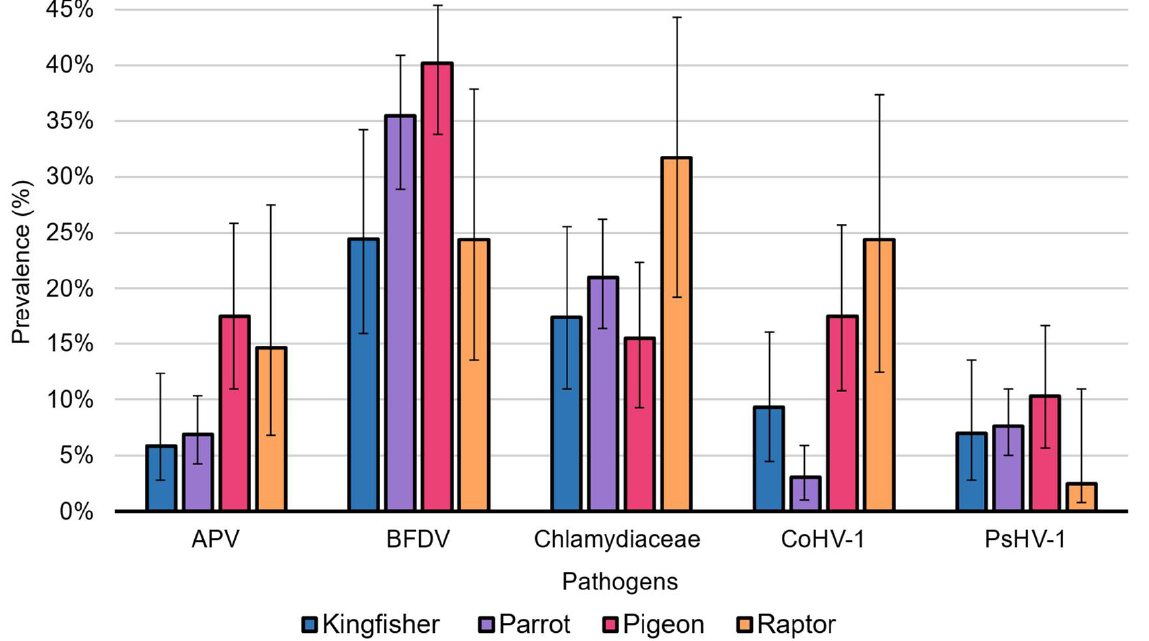
Figure 2. Pathogen prevalence within each sampled avian category. This histogram compares the percentage prevalence ( y -axis) of Avipoxvirus , BFDV, Chlamydiaceae , CoAHV1 and PsAHV1 ( x -axis) between each sampled avian category in this study. Histogram error bars represent the 95% confidence interval for the overall prevalence of each pathogen detected within sampled avian categories. Table 1. qPCR detection rates of beak and feather disease virus (BFDV), Chlamydiaceae , psittacid al-